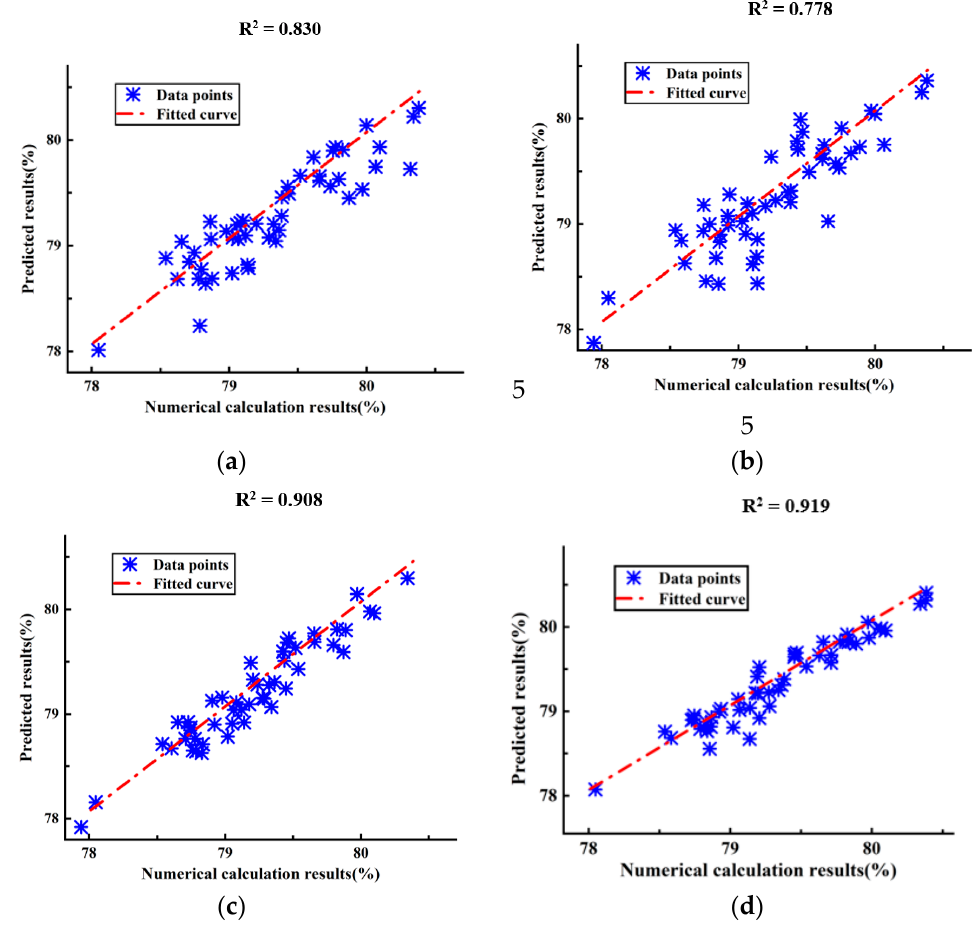
Figure 8. Corresponding values of R 2 for polynomials: cubic hierarchy ( a ), quartic hierarchy ( b ), cubic non-hierarchy ( c ), quartic non-hierarchy ( d ). Table 6. Design variable values before and after optimization.